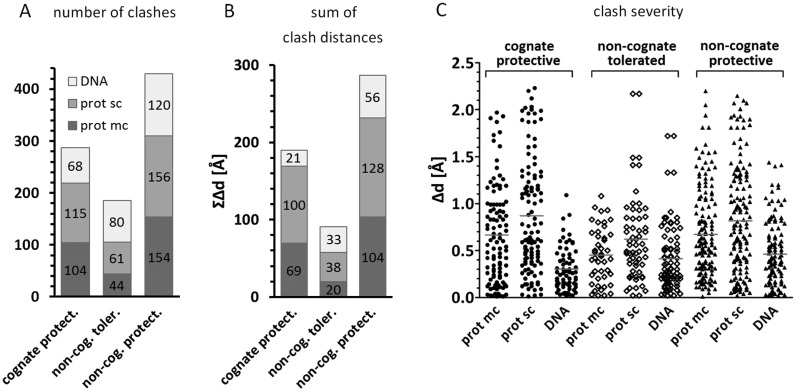
Distance based clashes divided according to the type of atom contacting the methyl group. For each enzyme one representative structure was chosen and methyl groups of the two DNA strands were analyzed independently. In case of multiple molecules in the asymmetric unit, only one was chosen. (A) number of clashes; (B) sum of clashes; (C) clash severity, each dot represents one clash and horizontal lines represent mean. Prot sc—protein side chain, prot mc—protein main chain.